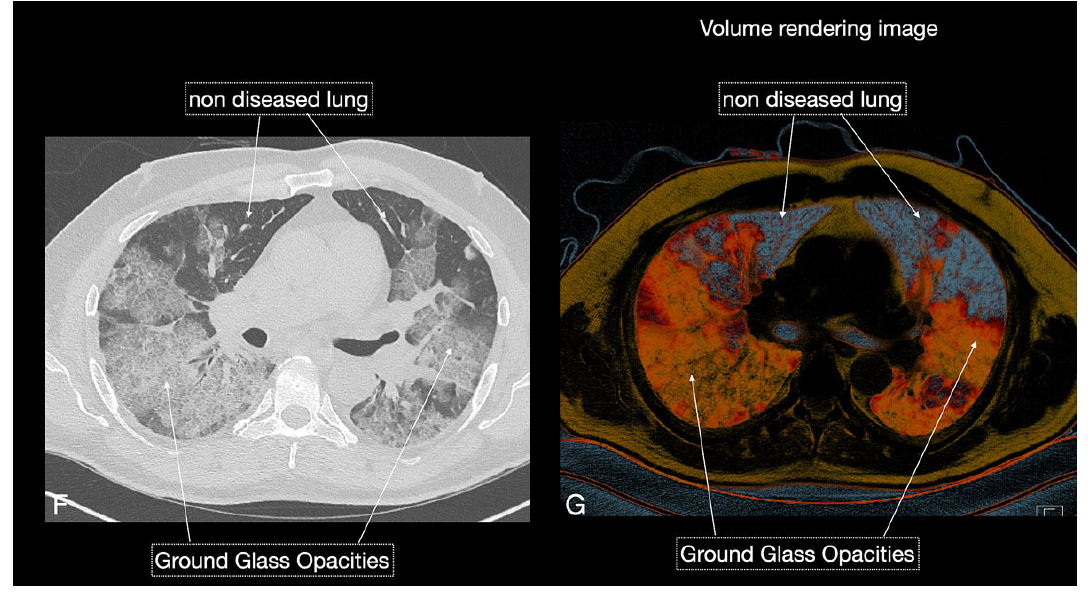
tree-in-bud or centrilobular nodularity or lobar consolida- tions are considered not typical of a COVID-19